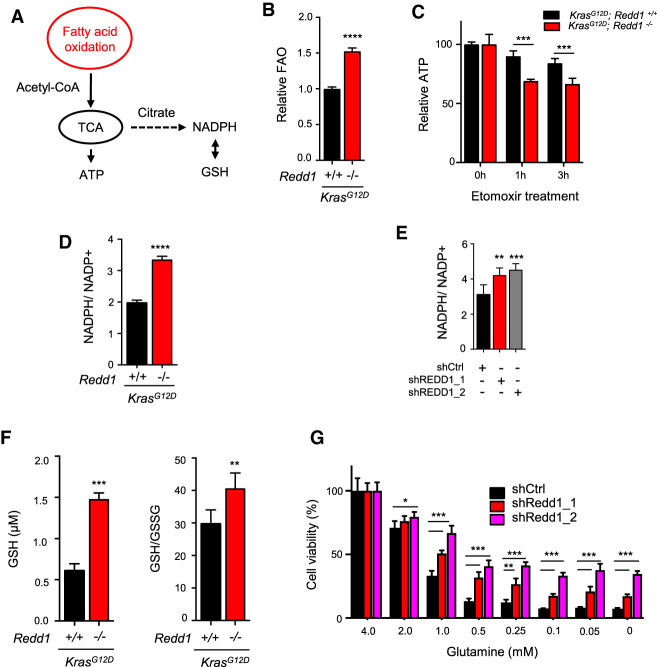
REDD1 loss potentiates fatty acid oxidation (FAO) to drive metabolic dependencies on redox and energy homeostasis. (A) Schematic showing proposed pathways linking FAO to redox and energy homeostasis. (B) Increased FAO in primary KRMEFs compared with KMEFs under serum starvation for 3 h as measured by 3H palmitate labeling. Bar graph shows mean of three experiments. Error bars indicate SD. (C) Rapid ATP depletion in KRMEFs compared with KMEFs with FAO inhibition by etomoxir treatment (250 µM) for 1 h, assessed by ATP Cell Titer-Glo assay. Bar graph shows mean from duplicate experiments. (D) Increased NADPH/NADP+ ratio in KRMEFs compared with KMEFs, assessed as described in the Materials and Methods. Graph shows mean of two experiments performed in duplicate. (E) Increased NADPH/NADP+ ratio in REDD1-ablated primary KPECS. Bars indicate mean of two experiments performed in duplicate. (F) Increased GSH concentration and GSH/GSSG ratio in KRMEFs as compared with KMEFs. (G) REDD1 ablation renders KPECs resistant to glutamine withdrawal. Cells were cultured in the denoted concentrations for 3 d. Data represents mean of three independent experiments. See also Supplemental Figure S3. Unless noted otherwise, all error bars denote SD. (*) P < 0.05; (**) P < 0.01; (***) P < 0.001; (****) P < 0.0001 by two-tailed t-test for all panels.